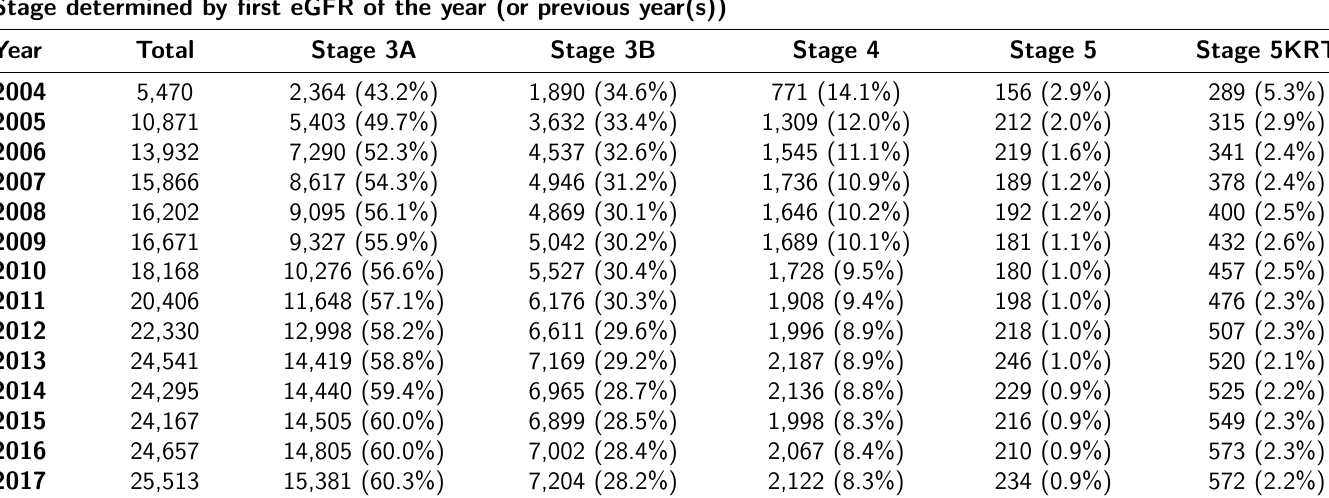
Supplementary table 4: CKD stages in each